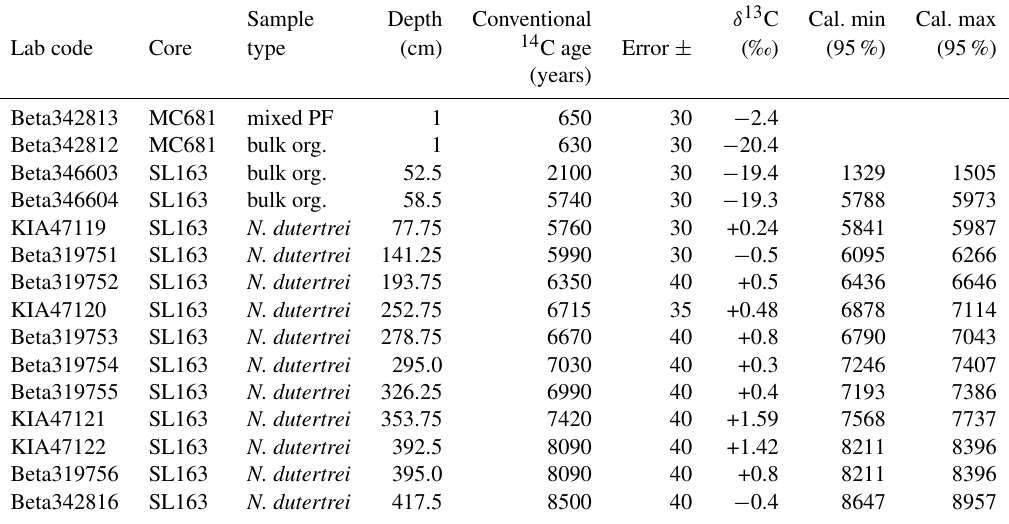
Table 1. Samples for radiocarbon dating with the organic compound used, dating results and calibrated ages using the Marine13 calibration curve (Reimer et al., 2013), and a reservoir correction of (cid:49)R = 231 ± 31years. Analyses were conducted at Beta Analytic in Miami, FL, USA (Beta), and the Leibniz Laboratory in Kiel, Germany (KIA).